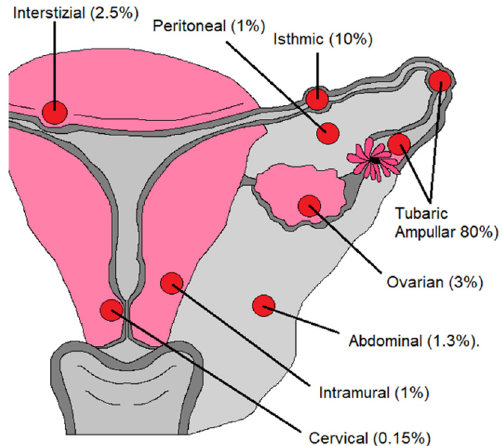
Figure 11. Abnormal implantation sites for ectopic pregnancy. Other less common sites include scarring of the ovary, abdomen, cervix, and